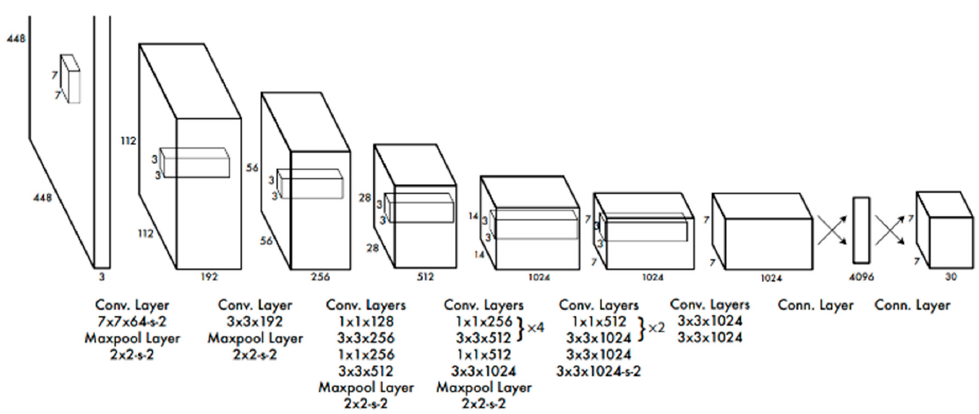
Figure 2. 24 convolutional layers followed by 2 fully connected layers for YOLO version 1